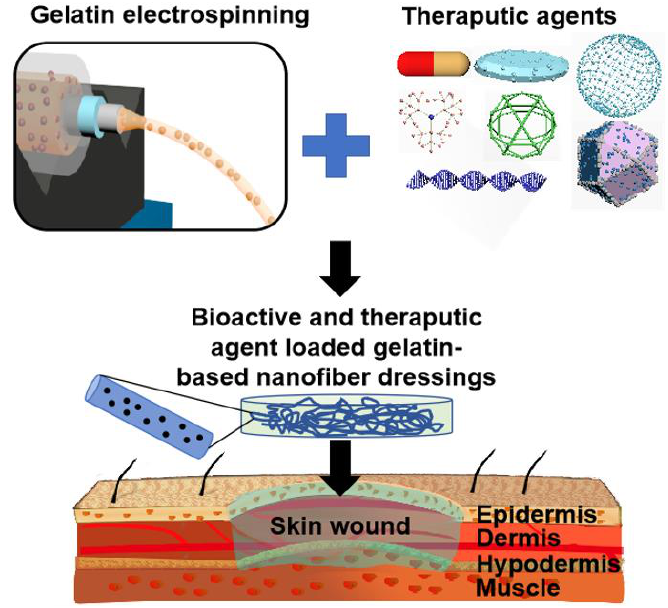
Figure 1. Schematic of the design and development of bioactive and therapeutic agent loaded gelatin-based nanofiber mats for wound treatment applications.